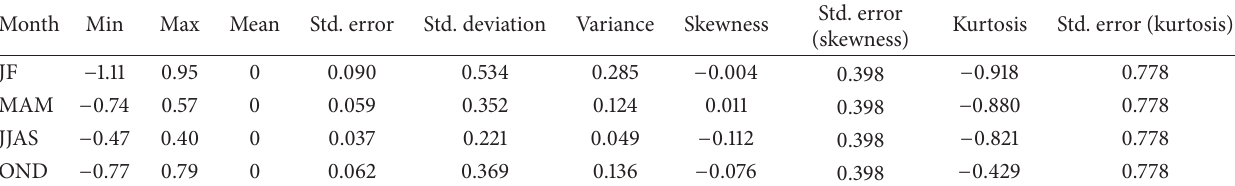
Table 4: General statistics of temperature at 850 hPa.